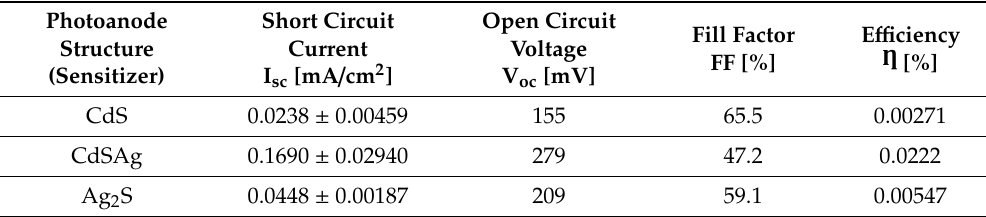
Table 1. Photovoltaic parameters of quantum dot sensitized solar cells constructed with biological Quantum Dots (QDs).